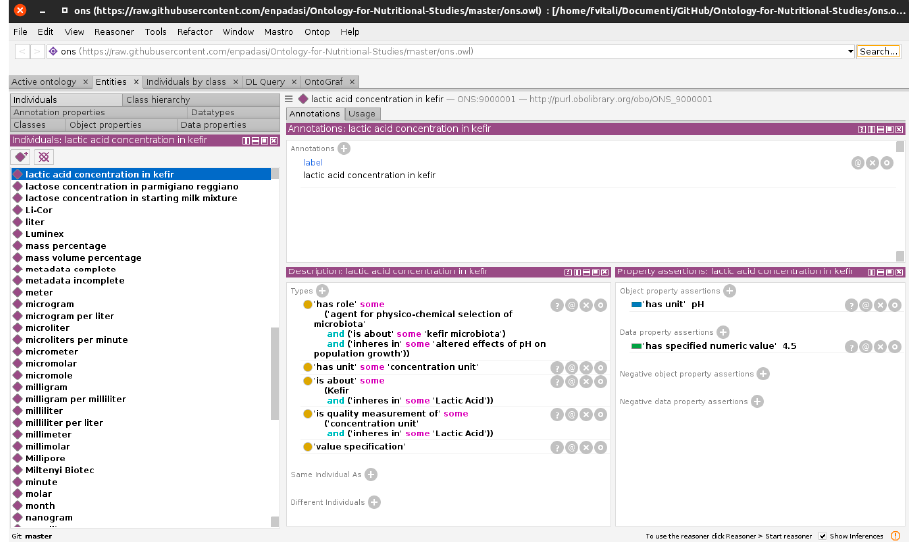
Figure 6. Screenshot taken from the Protégé ontology editing program, showing the assertion and axioms for individual ONS:9000001 (“lactic acid concentration in kefir”).